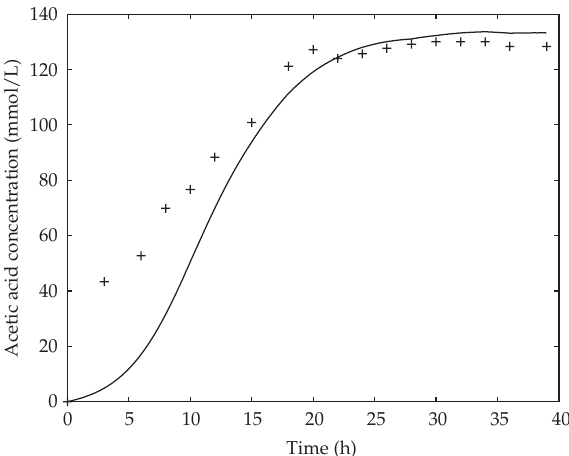
Figure 5: Comparison of acetic acid concentration between experimental data and computational results.